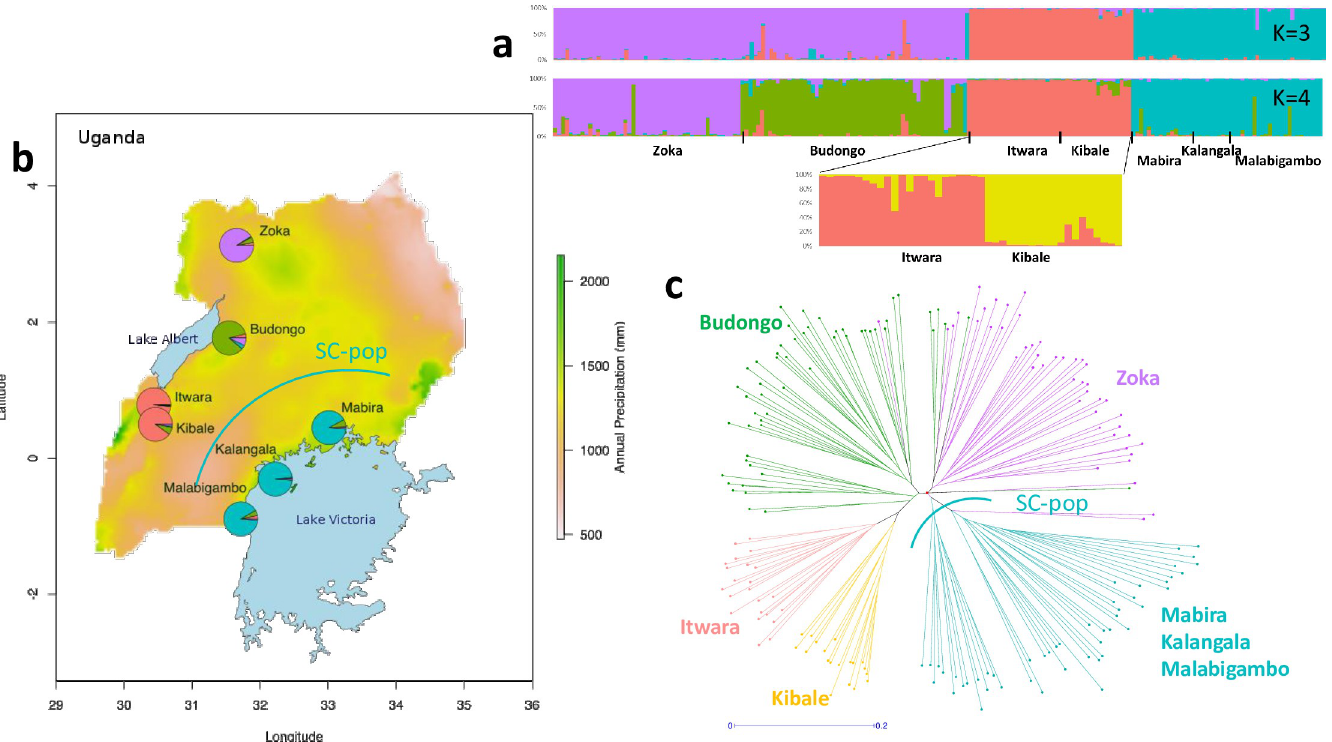
Fig 2. Genetic structure of Ugandan C . canephora native populations. a- Percentage membership of the 191 wild accessions to each of K = 3 or 4 population clusters as inferred by STRUCTURE based on 19 SSR loci. The substructure is presented below for Itwara and Kibale individuals with K = 2 sub-clusters. b- Geographical distribution on the Ugandan map with the annual precipitation variable (BIO12) of SSR genetic groups considered according to the STRUCTURE analysis at K = 4. Each location is depicted as a pie chart with the proportional membership of its alleles to each one of the four groups with colours according to graph a. c- Unrooted dendrogram produced using the unweighted neighbour-joining method based on genetic dissimilarity among the 191 accessions. The branch colours indicate accessions corresponding to the five clusters from the population structure analysis, as in a-. Individuals from Mabira, Kalangala and Malabigambo forests are intermixed within a same large southern-central population